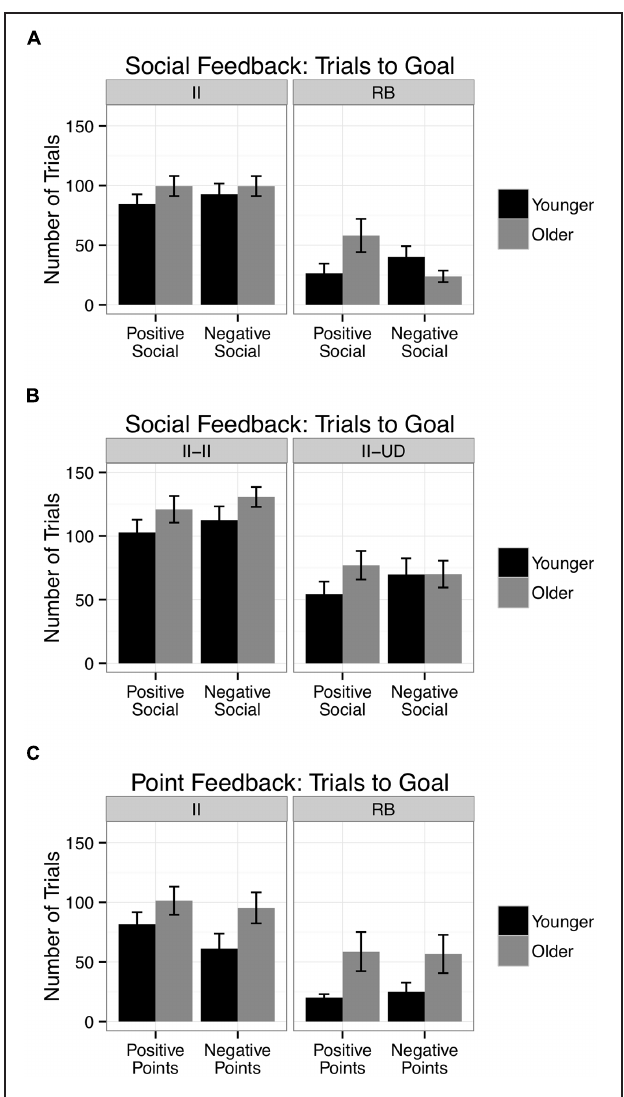
FIGURE 3 | The number of trials needed to learn the rule for older and younger adults given (A) rule-based (RB) and information integration (II) category structures in the happy- and angry-face-feedback conditions (B) within the information integration condition by strategy (II-II = information integration strategy; II-UD = unidimensional strategy) and (C) the rule-based and information integration tasks in the point gain and point loss feedback conditions (II = information integration structure; RB = unidimensional structure). SE bars are